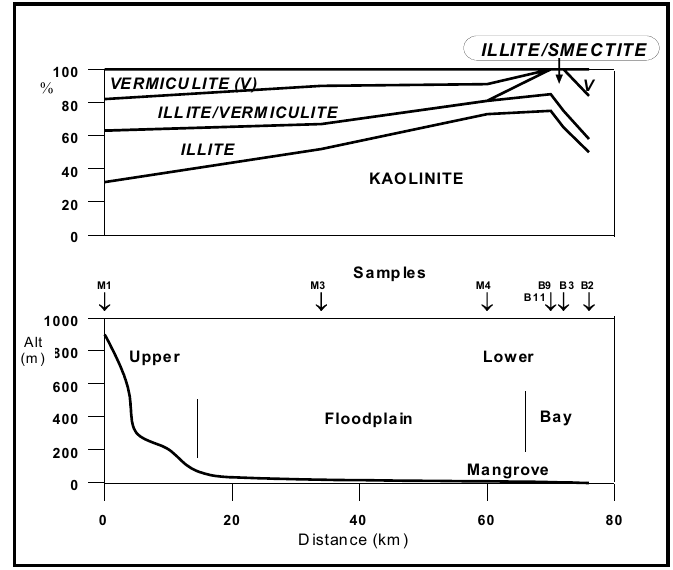
Fig. 3 – The relationship between clay mineral proportions and topographic profile of Macacu